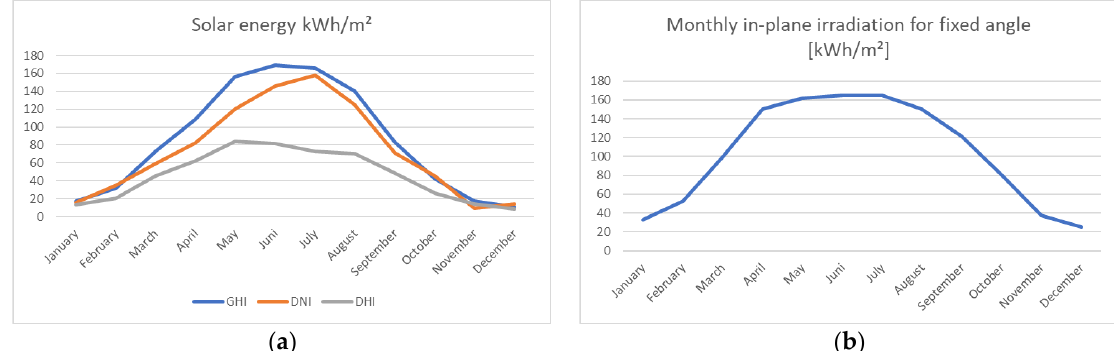
Figure 2. Average monthly amount of solar energy per square meter at the installation site: ( a ) GAfRE; ( b ) PVGIS.